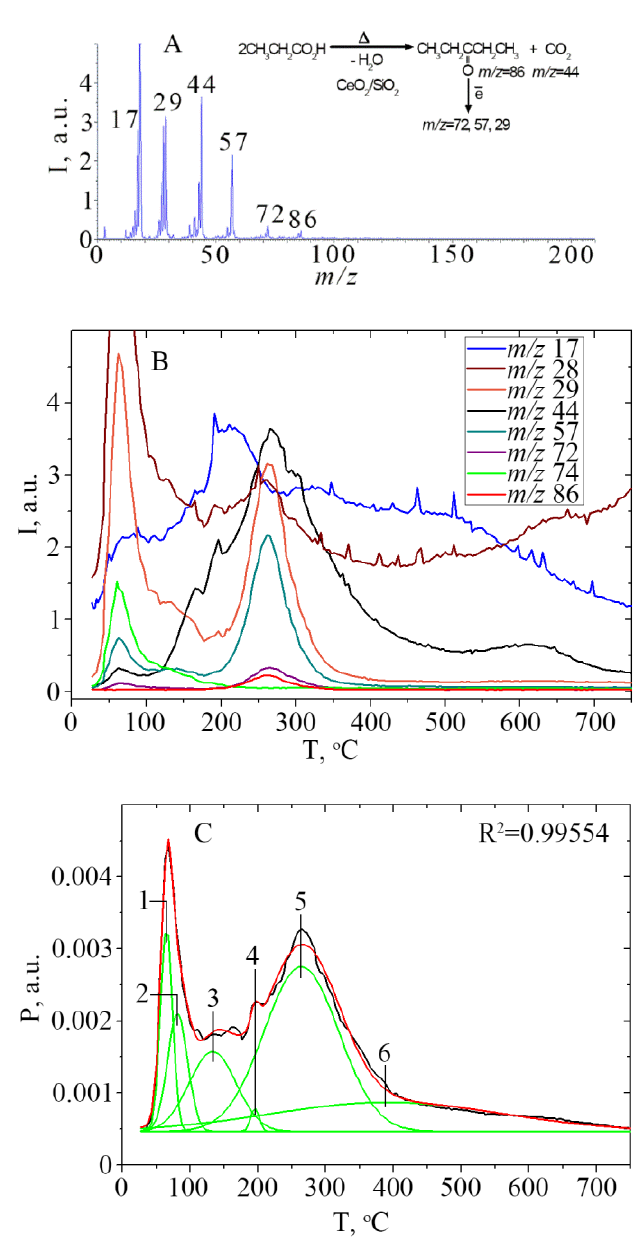
Figure 1. Catalytic pyrolysis of propionic acid supported on the nanocomposites CeO 2 / SiO 2 with low amount of CeO 2 (lCeSi) surface (0.6 mmol g − 1 ). ( A ) Mass-spectrum of pyrolysis products at 265 ◦ C, obtained after electron impact ionization. ( B ) temperature-programmed desorption curves (TPD curves) of the molecular ion of propionic acid with m / z = 74 and its fragment ions with m / z = 72, 44, 29, 28, 17 attributed to the desorption of the physically adsorbed and hydrogen-bonded acid. TPD curves attributed to the ketonization products: molecular ion of CO 2 with m / z = 44, and molecular ion of 3-pentanone with m / z = 86 and its fragment ions with m / z = 72, 57, 29. TPD curve attributed to water desorption: fragment ion of molecular ion of water with m / z = 17. ( C ) Vapor pressure measured as a function of temperature (P / T curve); deconvolution of P / T curve (R 2 = 0.99554); experimental data is black line, fitting curve—Red line, Gaussians—Green line.